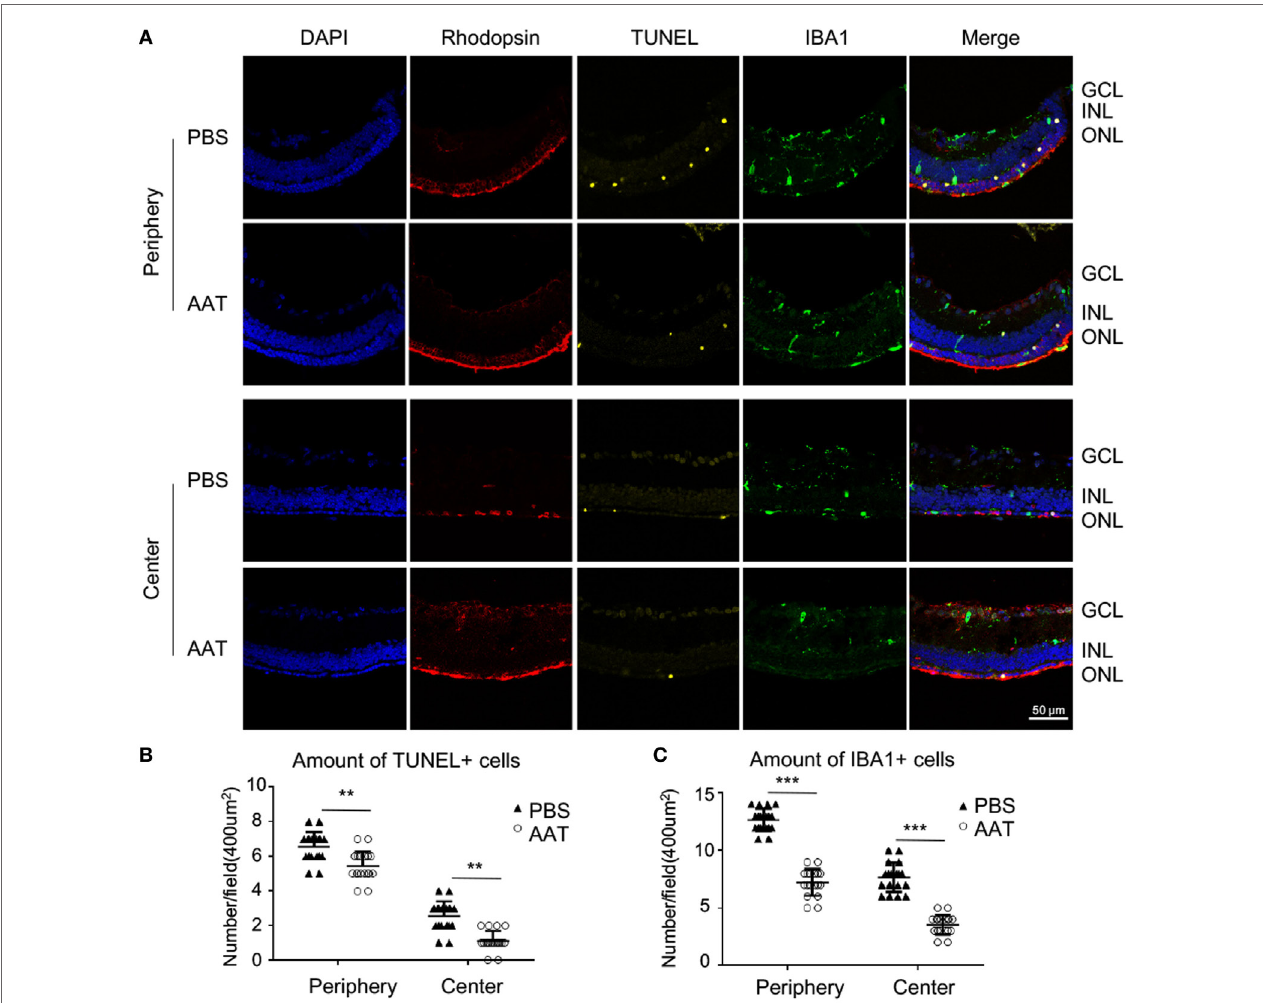
FigUre 5 | Protective effect of alpha-1 antitrypsin (AAT) on degenerative rods. (a) The representative images of immunostaining on retinal sections revealed that rhodopsin-positive rod photoreceptors were scattered in the PBS-treated rd1 mice, but widely distributed and well-organized in the outer nuclear layer after AAT treatment. The TUNEL + apoptotic cells decreased in AAT supplement group, whereas the amount of IBA1 + microglia also decreased comparing with the PBS- treated ones. The location “Center” refers to the panoramic view area 1 in Figure 3a , and “periphery” refers to the area 3. Scare bar, 50 µm. Statistical analysis of the TUNEL + (B) and IBA1 + cells (c) revealed that all their amounts significantly decreased either in the center or periphery. Six sections of each retina and three retina of each group were used for analysis. ** p < 0.01, *** p < 0.001 (two-tailed unpaired t